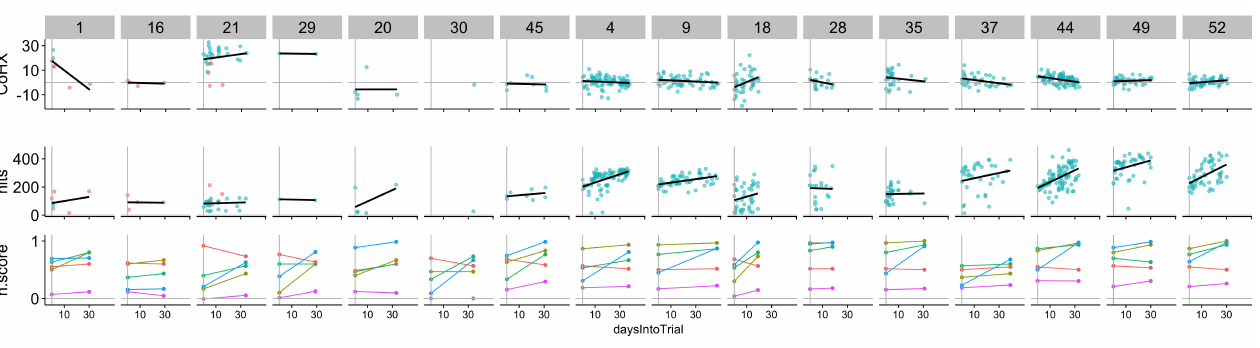
Figure 5. Per session performance aggregates and their linear trend lines of all USN patients (1, 16, 21, 29), all attention deficit patients in the test group (20, 30, 45), and a few examples (4-52) from other participants over time. Top: Center of Hit along the x-axis (CoH ), Middle: number of hits; Bottom: normalized scores of control tests Data points in red denote session data that was x misclassified (false positive or false negatives) by the logistic regression.